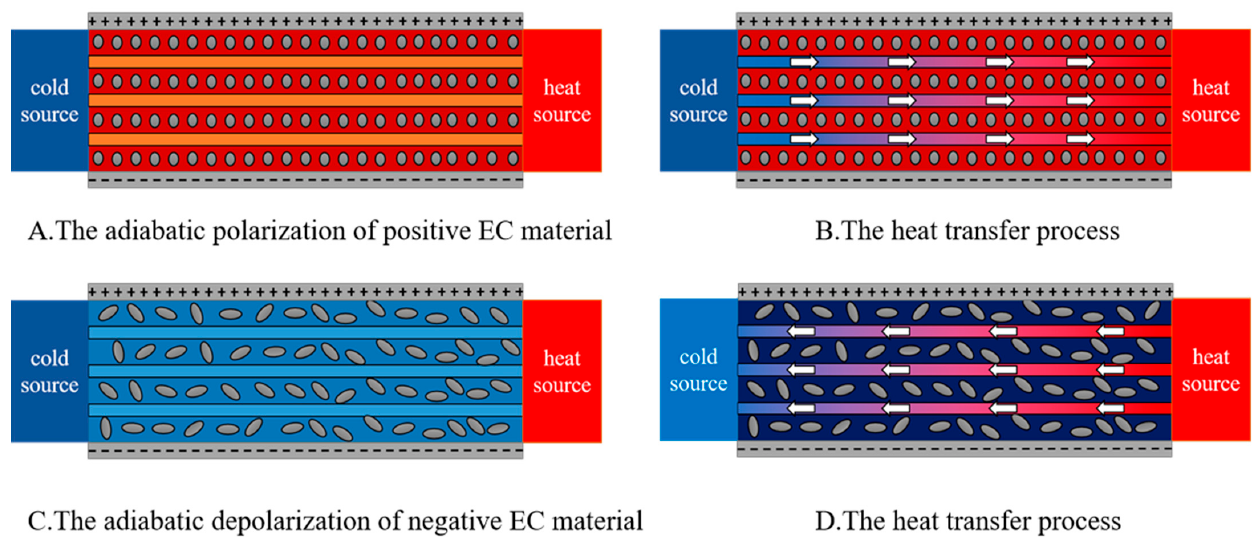
Figure 3. Schematic diagram of the device principle where the arrows represent the flow direction of the fl uid.